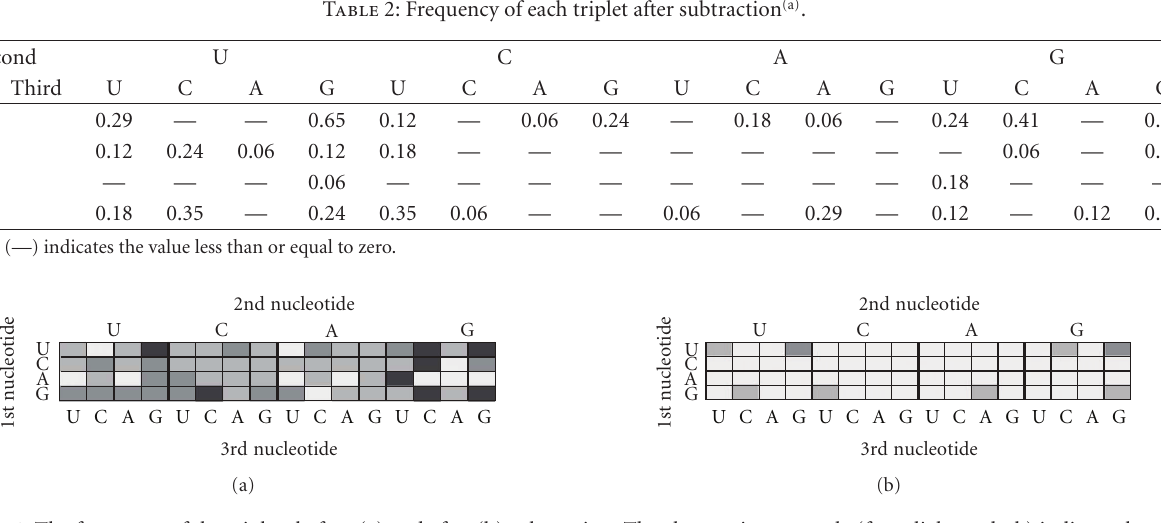
Figure 4: The frequency of the triplets before (a) and after (b) subtraction. The changes in gray scale (from light to dark) indicate changes